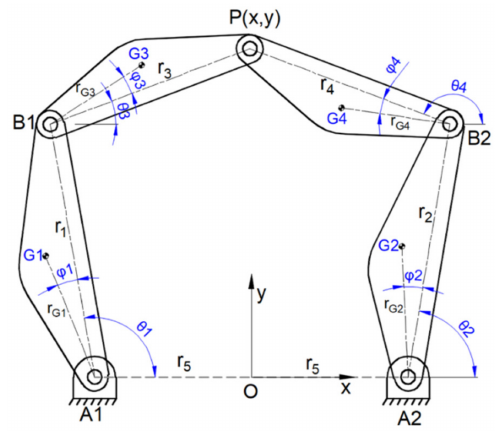
Figure 2. The five-bar